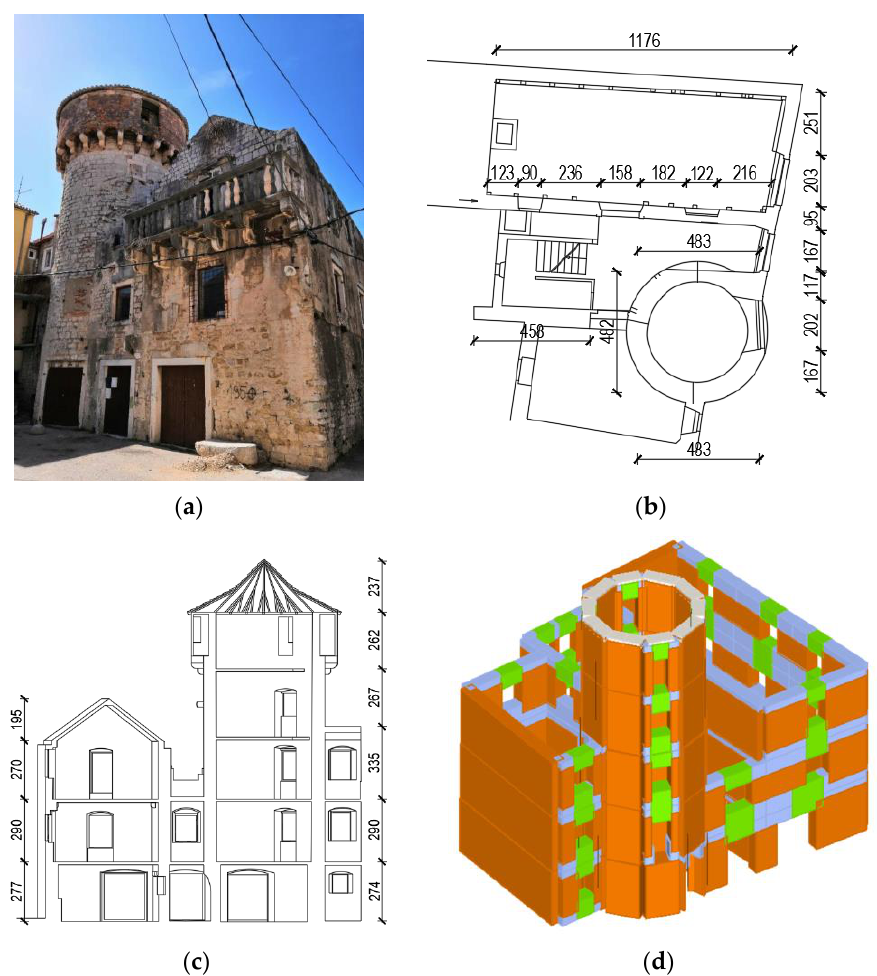
Figure 8. Cambi Tower: ( a ) photo of the building; ( b ) ground floor plan; ( c ) section view; ( d ) structural model.